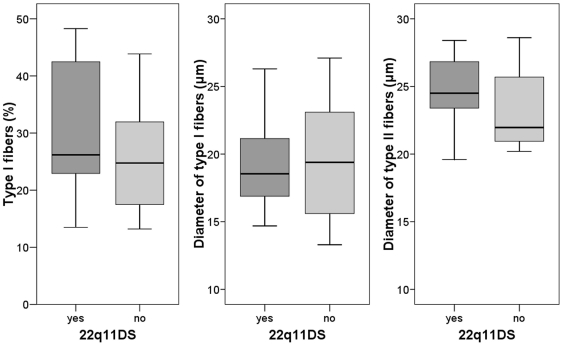
Muscle fiber type measurements for children with and without 22q11DS.Bands, means. Boxes, 25th–75th percentiles. Whiskers, 95% confidence intervals.